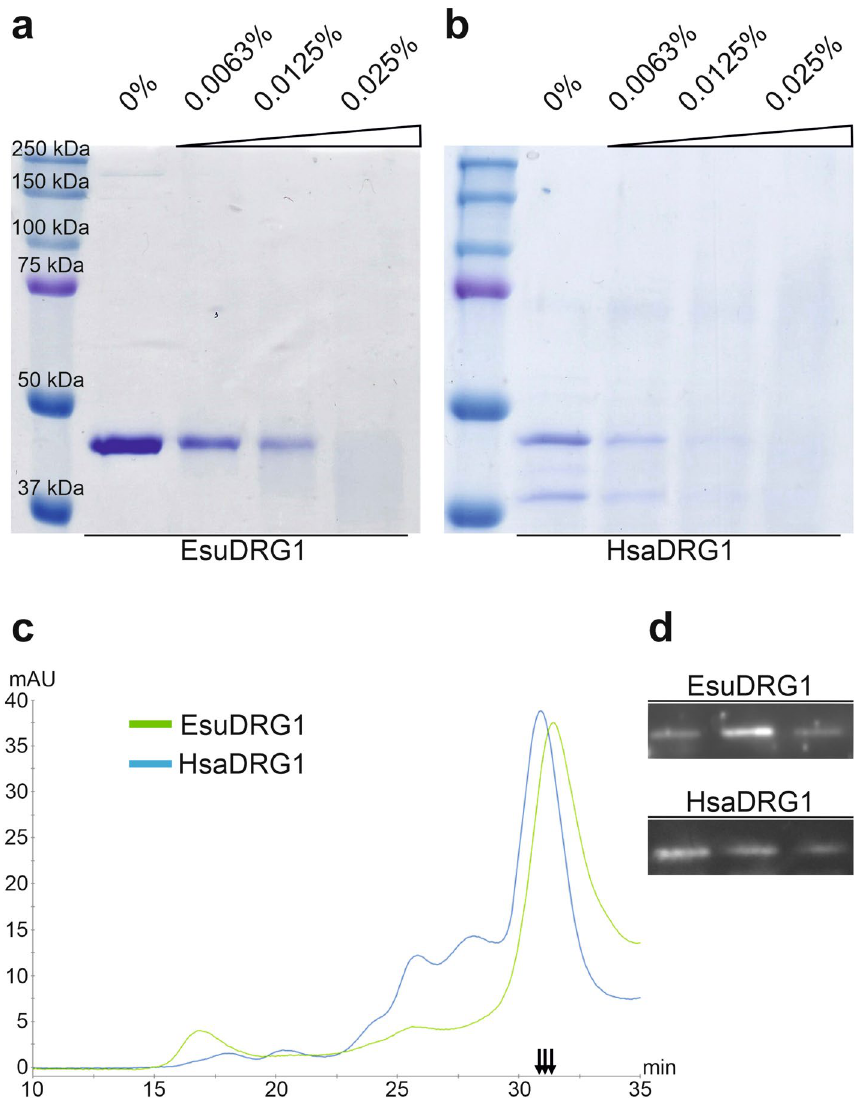
Figure 4. The sponge and human DRG1 proteins predominantly exist in the monomeric state. ( a ) Crosslinking of EsuDRG1 and ( b ) HsaDRG1. Glutaraldehyde was added up to a final amount of 0.025%. Reactions were incubated at 25 °C for 5 min. ( c ) SEC was performed by loading purified recombinant proteins EsuDRG1 (green line) and HsaDRG1 (blue line) onto a Superdex 200 Increase 10/300 GL column, calibrated for molecular mass analysis by a series of standard proteins. ( d ) Western blot analysis on selected fractions (indicated by arrows) with antibodies against His-tag. Original gels and blots are presented in Supplementary Fig.